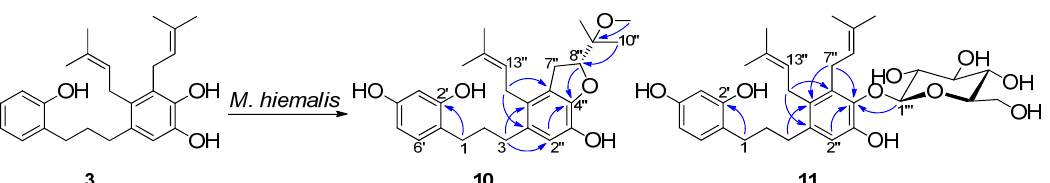
Figure 4. Metabolites of kazinol F ( 3 ) transformed by M. hiemalis . Selected HMBC correlations ( 1 H → 13 C) are indicated by arrows.